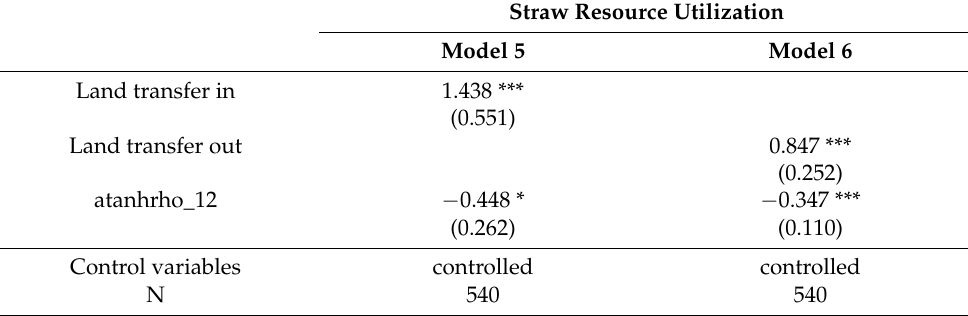
Table 4. Robustness